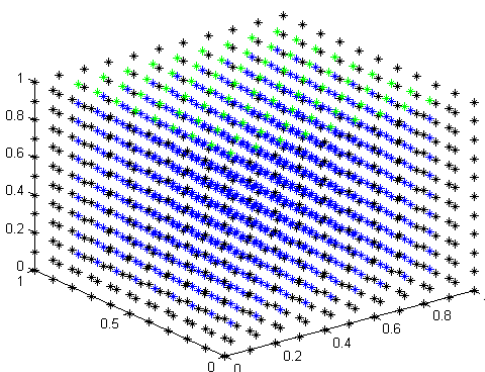
Figure 5. First regular cloud of points for the 3D examples (Cloud 3).